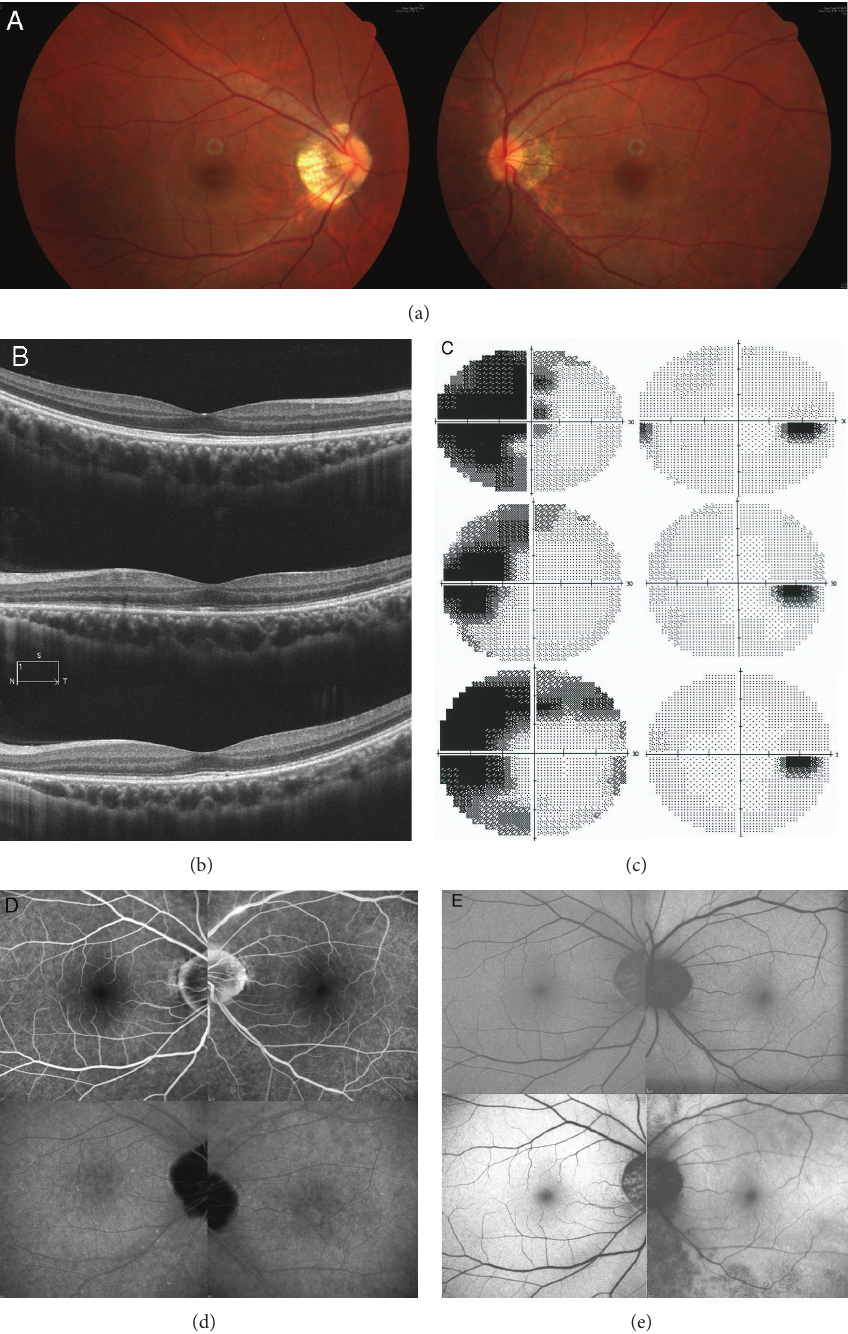
Figure 2: Color fundus in case 5 shows tessellated fundus in both eyes with temporal conus (a). Optical coherence tomography showed normal ellipsoid zone in the right eye (b, upper) and disrupted ellipsoid zone at the macular and peripapillary area with central sparing in the left eye (b, central) in the acute stage. Recovery of the ellipsoid zone was noted at the macular area 4 months later; however loss of the outer nuclear layer and the ellipsoid zone adjacent to the disc was also noted (b, lower). Visual field test at initial presentation showed dense central, temporal scotoma, and faint circumferential peripheral visual field defect in the left eye (c, upper). Small nasal scotoma and faint upper nasal scotoma were also noted in the left eye. The visual field defect in the left eye reduced a little 3 months later after oral prednisolone treatment (c, middle). An enlarged visual defect was noted after tapering of the steroids (c, lower). Fluorescein angiograph showed mild segmental periphlebitis in the left eye at the disease onset (d, upper). Indocyanine green angiography taken concurrently revealed some suspicious hypofluorescent spots at the posterior pole and arcade area in the left eye (d, lower). Fundus autofluorescence (FAF) imaging at acute phase showed some suspicious hyperautofluorescent spots at upper aspect of disc (e, left). Follow-up FAF 2 years later showed diffuse hypoautofluorescence at peripapillary area and area lower to the lower vascular arcade (e,